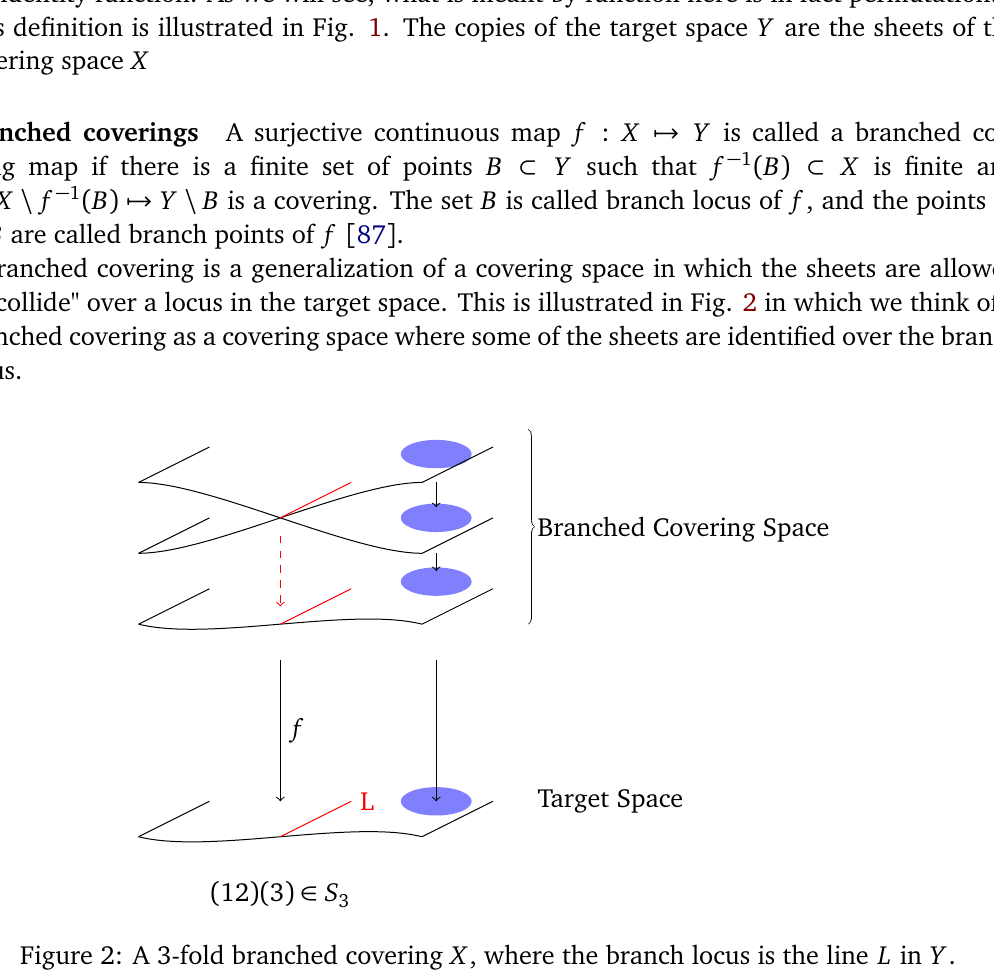
Figure 2: A 3-fold branched covering X , where the branch locus is the line L in Y